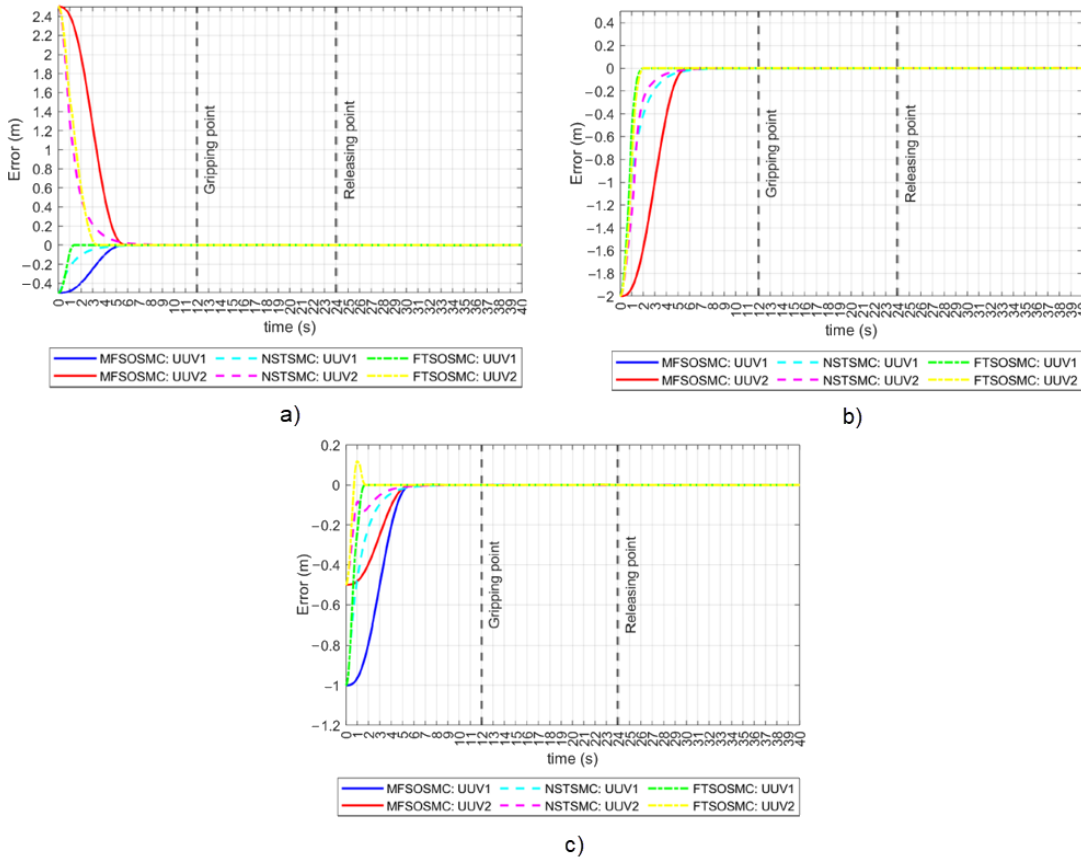
Figure 10. Tracking error for all the controllers (no external disturbances). ( a ) 𝑥 − 𝑎𝑥𝑖𝑠 . ( b ) 𝑦 − 𝑎𝑥𝑖𝑠 . ( c ) 𝑧 − 𝑎𝑥𝑖𝑠 .